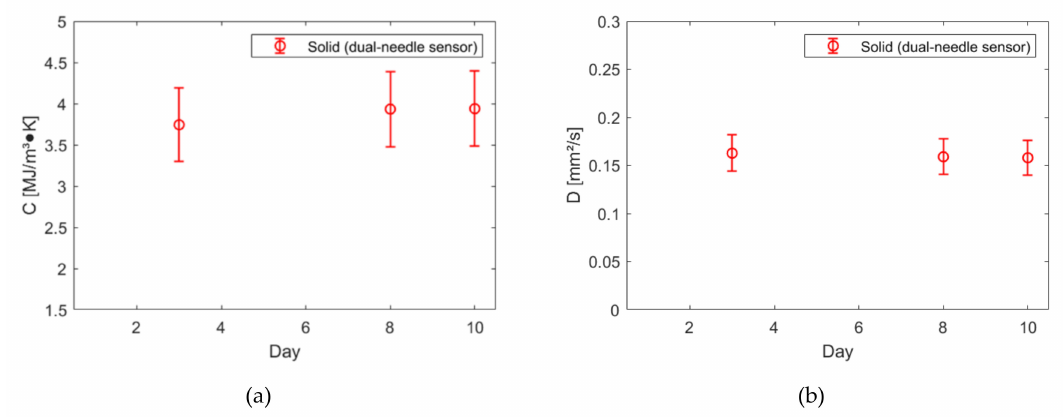
Figure 3. Volumetric heat capacity ( a ) and thermal di ff usivity ( b ) of the solid phantom measured with the dual-needle sensor over